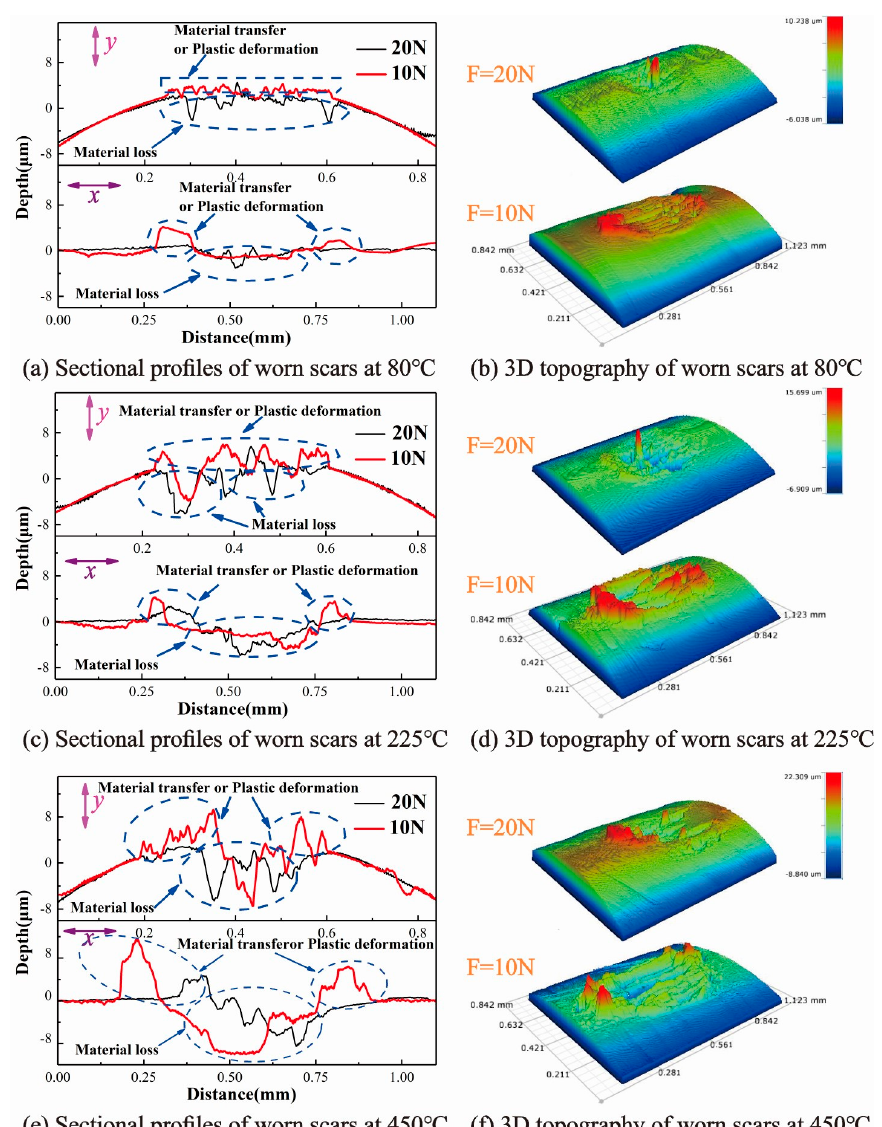
Figure 5. Sectional profiles and 3D topography of worn scars under different normal loads, D = 50 μ m.